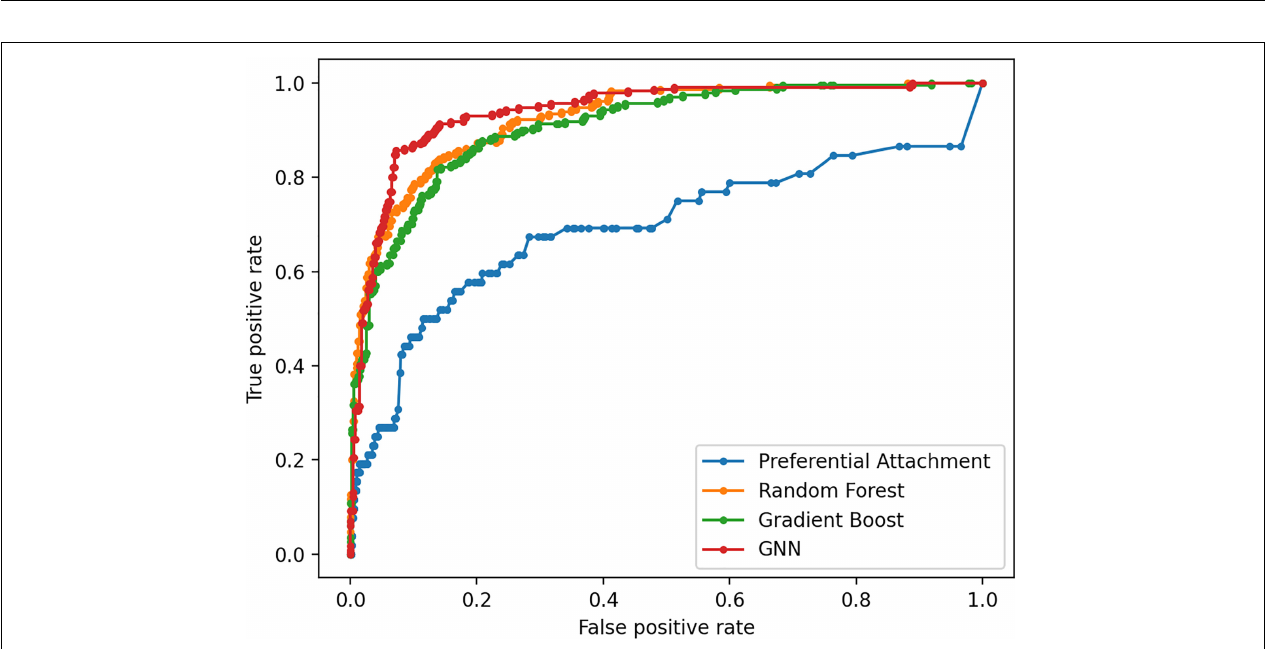
FIGURE 5 | Receiver Operating Characteristic curves for link prediction between genes differentially regulated in muscle atrophy and diseases in the GDKG using PA, RF, Gboost, and GNN methods.